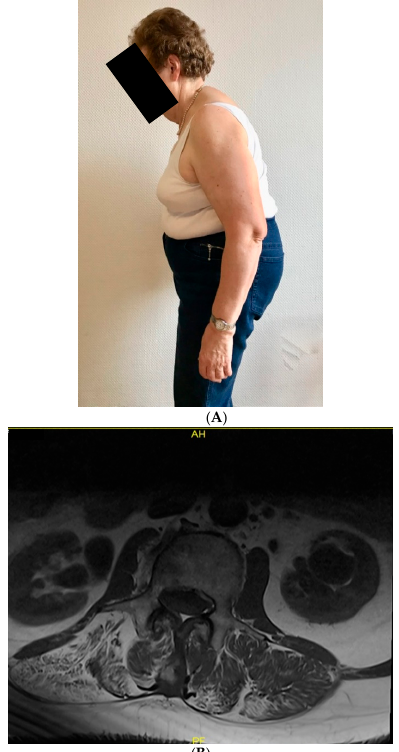
Figure 1. ( A ) Camptocormia in the patient as the main clinical symptom: upright standing is only possible with bended knees, indicating the severity of camptocormia and ( B ) transversal T1- weighted spinal MRI showing a significant fatty degeneration of the paravertebral lumbar spine muscles.